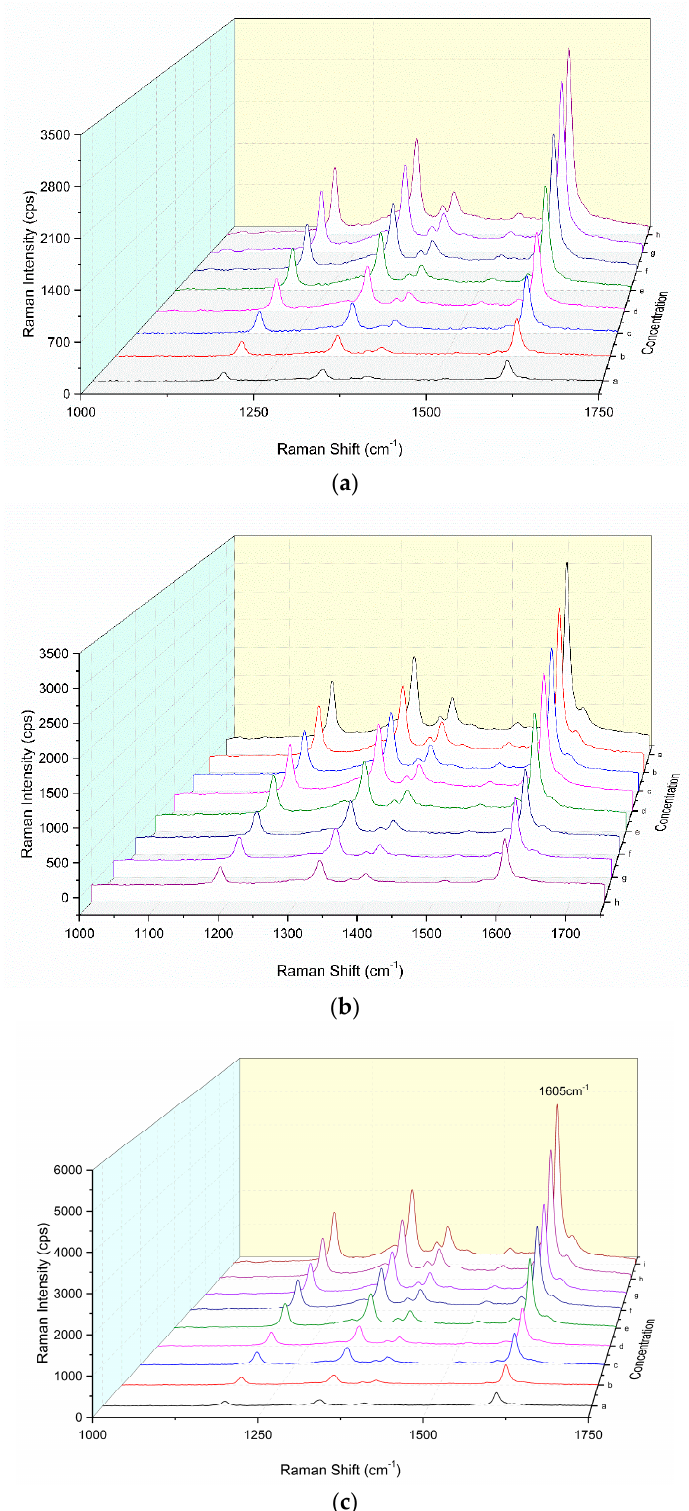
Figure 2. SERS spectra of a CD NAg2 -H 2 O 2 -DBD-AgNPs system. ( a ) 0.13 mmol/L H 2 O 2 + 33 μ mol/L DBD + 0.11 mmol/L AgNPs, a–h were 0, 0.011, 0.057, 0.113, 0.17, 0.227, 0.34, and 0.45 mg/L CD NAg2 , respectively. ( b ) 0.45 mg/L CD NAg2 + 0.13 mmol/L H 2 O 2 + 33 μ mol/L DBD + 0.11 mmol/L AgNPs, the a–h were 0, 3.1, 7.2, 15.5, 20.7, 25.8, 31, and 36.2 nmol/L aptamer (Apt). ( c ) 25.8 nmol/L Apt + 0.45 mg/L CD NAg2 + 0.08 mmol/L H 2 O 2 + 0.025 mmol/L DBD + 0.11 mmol/L AgNPs, a–i were 0, 0.03, 0.15, 0.3, 0.5, 0.7, 0.9, 1.2, and 1.5 µ g/L acetamiprid (ACT),